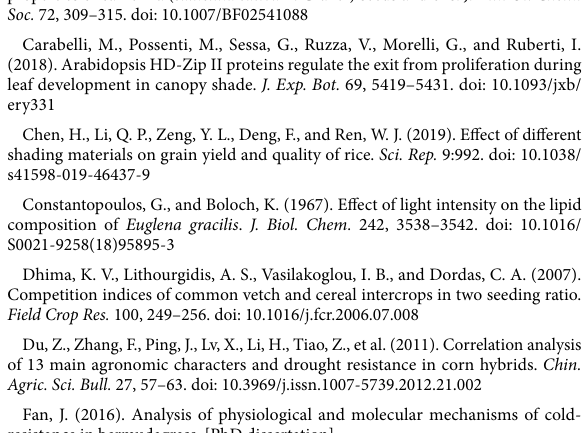
SUPPLEMENTARY FIGURE 1 Phenogram illustration of the mean first day of anthesis and flowering duration of camelina across the 16 camelina genotypes to different shade treatments in 2020–2021 (A) and 2021–2022 (B)